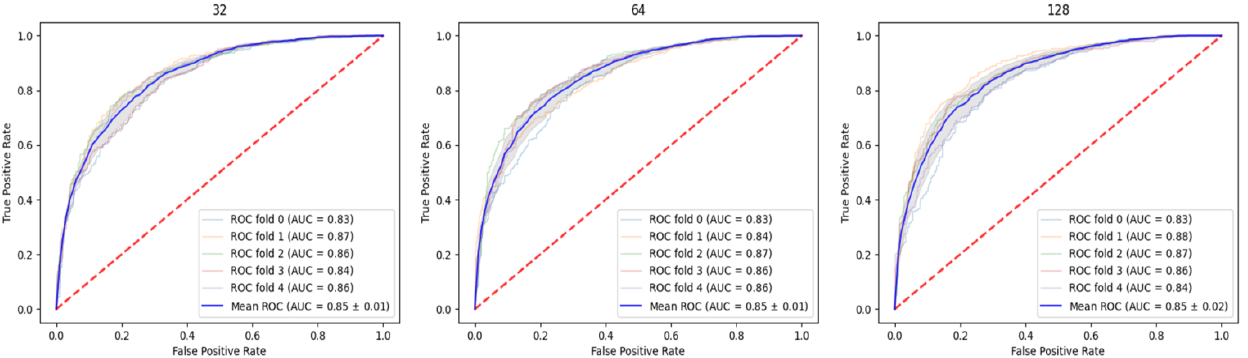
Figure 1. This figure shows the ROC curve and AUC value of the 32-dimensional, 64-dimensional, and 128-dimensional features of the node under the five-fold cross-validation. Among them, the blue curve is the average ROC and the corresponding mean, and the mean is around 0.85. Other colors correspond to the ROC curve and AUC value of each fold.